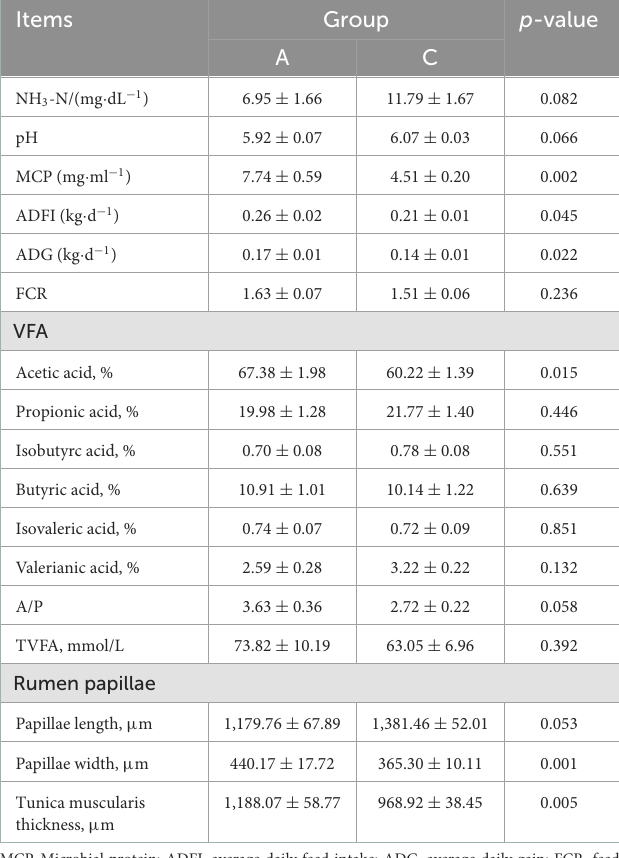
TABLE 2 Effects of different NDF/starch starter on production performance, rumen fermentation parameters, and rumen papilla development in